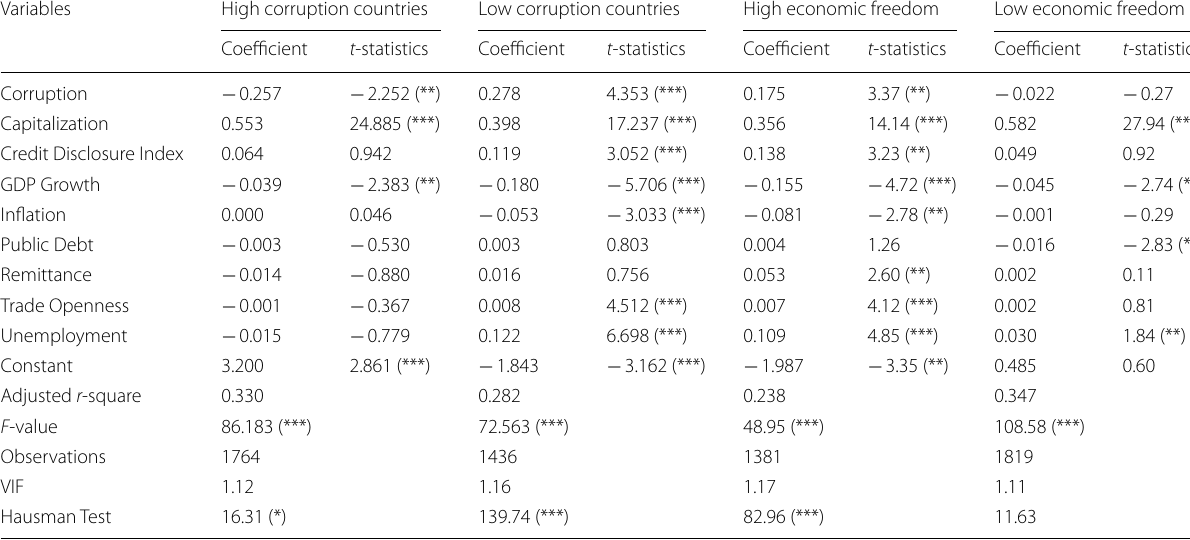
Table 7 Sub-sample analysis